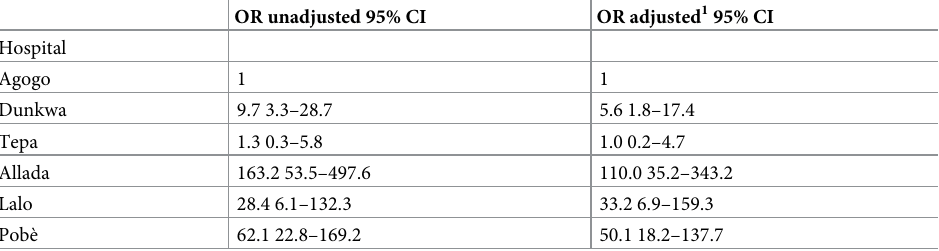
Table 3. Unadjusted and adjusted odds ratios for